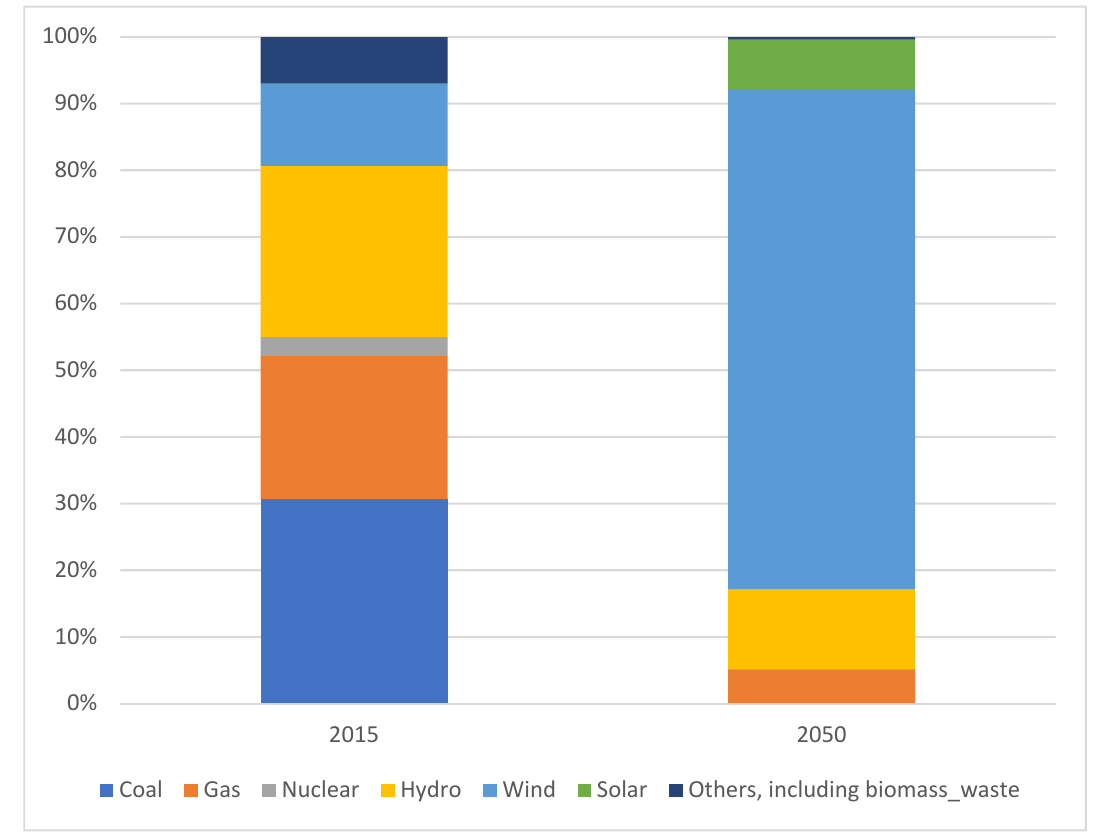
Figure 4. Electricity production by technologies of the WTM/RCOT for SSP3 “inequality”. Source: own elaboration based on the WTM/RCOT results.